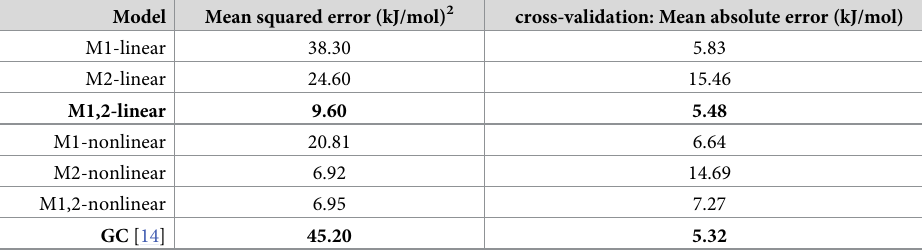
Table 2. Details of prediction accuracy and cross-validation scores for different regression